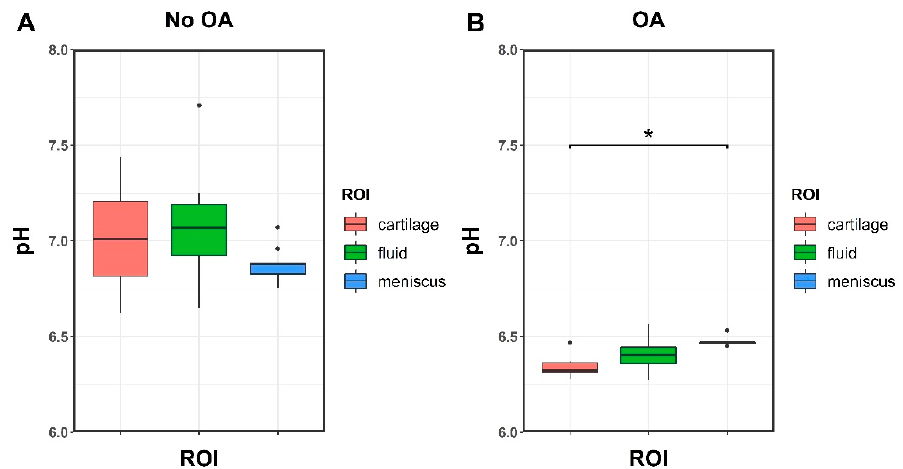
Figure 4. Boxplots of mean pH measurements versus ROIs in patients without OA ( A ) and with advanced OA ( B ). No significant differences were found, except for the pH of cartilage and meniscus in the OA group ( p = 0.024). “*”: p values lower than 0.05; “•”: outliers.